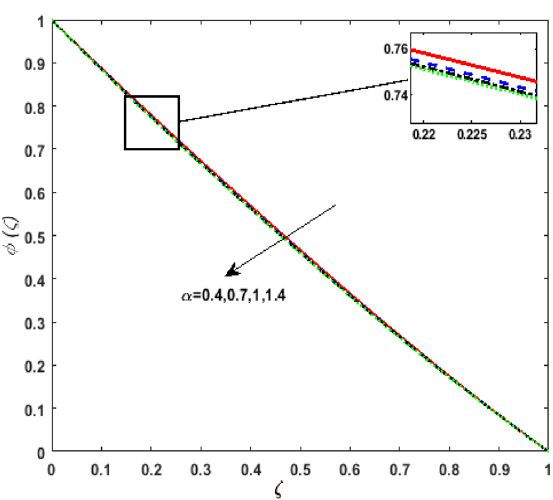
Figure 18. Effect of temperature difference parameter α on concentration φ(ζ) .